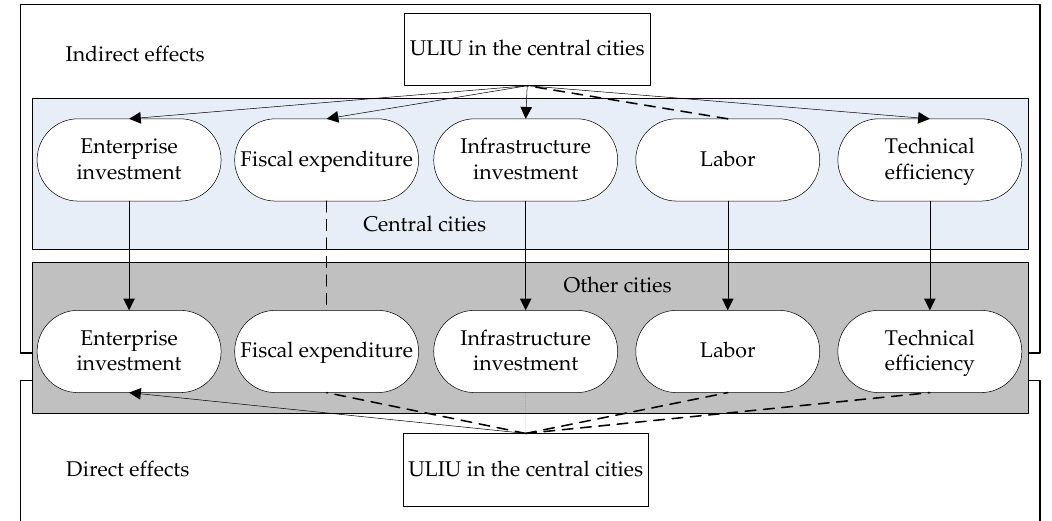
Figure 5. The impacts of ULIU on the production factors in urban agglomerations.